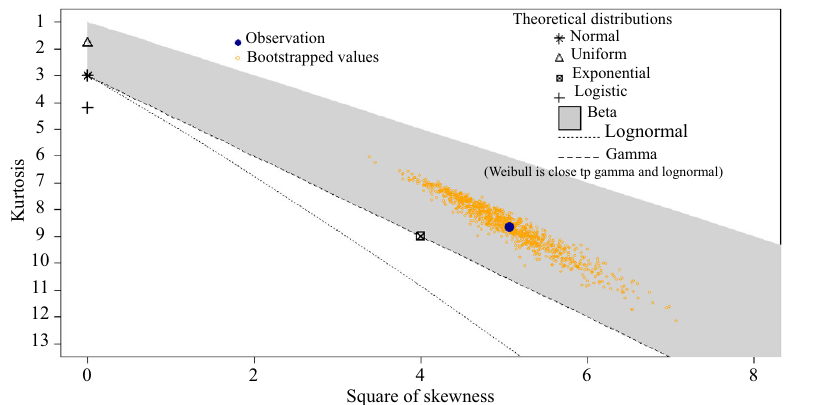
Fig. 5 Cullen and Frey graph with a bootstrapped value of 1,000 for BW data